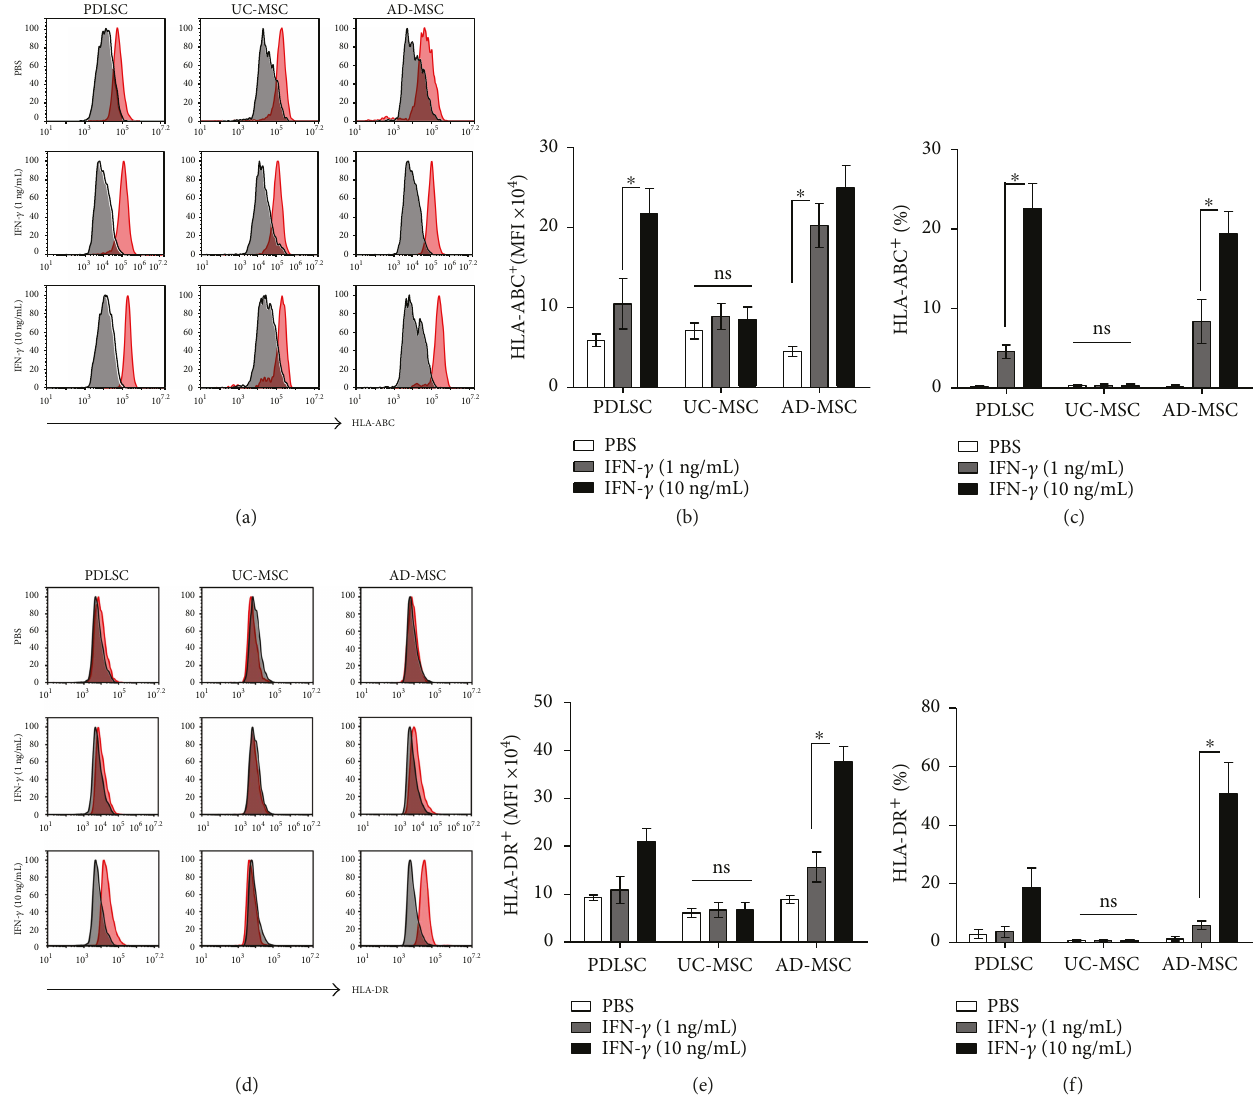
Figure 6: The e ff ects of IFN- γ on the expression of HLA-ABC and HLA-DR. PDLSCs, UC-MSCs, and AD-MSCs at passage fi ve were cultured without IFN- γ or with 1 or 10 ng/mL IFN- γ for 48 hours. Subsequently, cells were stained for (a) HLA-ABC and (d) HLA-DR, and the MFI values (b and e) and positive cell rates (c and f) were analyzed. Black histograms indicate negative controls, and red histograms represent MSCs stained with the indicated antibodies. All experiments were performed independently at least three times. The graph shows the means and SEMs. p values were obtained by ANOVA followed by Tukey ’ s post hoc test. ∗ p < 0 05 and ns: not signi fi